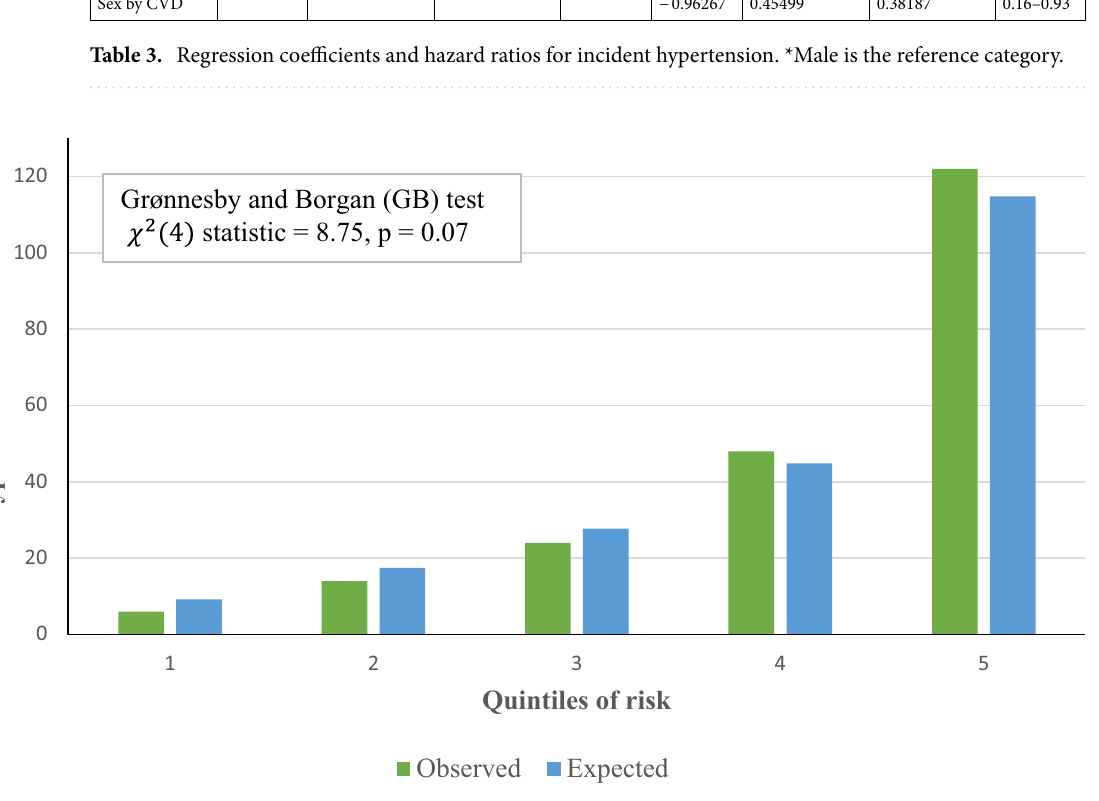
Figure 1. Grønnesby and Borgan (GB) goodness-of-fit test of the risk prediction model for incident hypertension in the validation